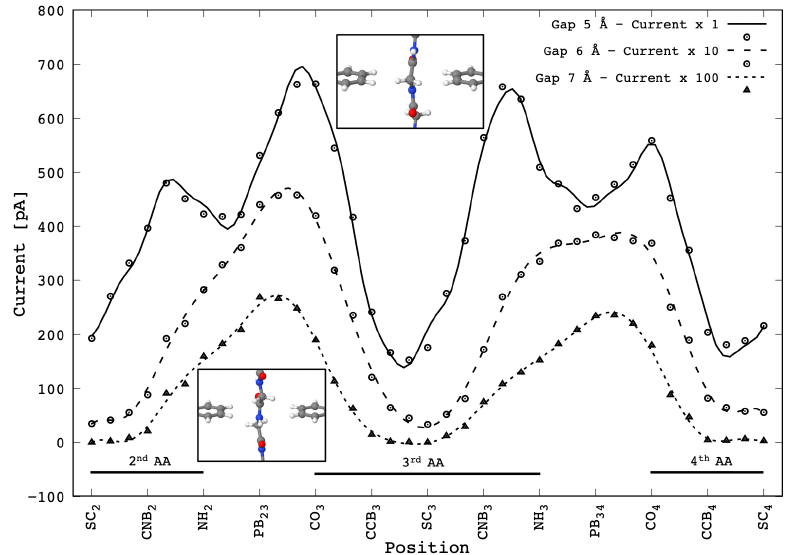
Figure 4. Tunneling current signals flowing across the 2-ZGNR nano-gap devices of different sizes (5 Å, 6 Å, 7 Å) with an applied bias of ∆ V = 1 V during the translocation of the Gly penta-peptide through the nano-gap. The labels in the x-axis represent the atomic groups that are located in the middle of the gap during the translocation— CO i , NH i and SC i are the configurations with, respectively, the carbonyl, the amine and the side chain group belonging i-th amino acid right in the center of the nano-gap. Similarly for CNB i and CCB i with reference to the C-N and the C-C middle bonds of the i-th amino acid and for PB ij that indicates the peptide bond between the i-th with the j-th amino acid. Only the three central amino acids are considered (see text). The scale factors of the current signals for the 5, 6 and 7 Å wide gaps are respectively 1, 10 and 100. All the curves have minima with the side-chain located in the middle of the gap ( SC 2 , SC 3 and SC 4 configurations, see text). Note how the characteristic double peak [4] per peptide bond evolves into a broad structured peak, centered at PB 23 and PB 34 , as the gap size is